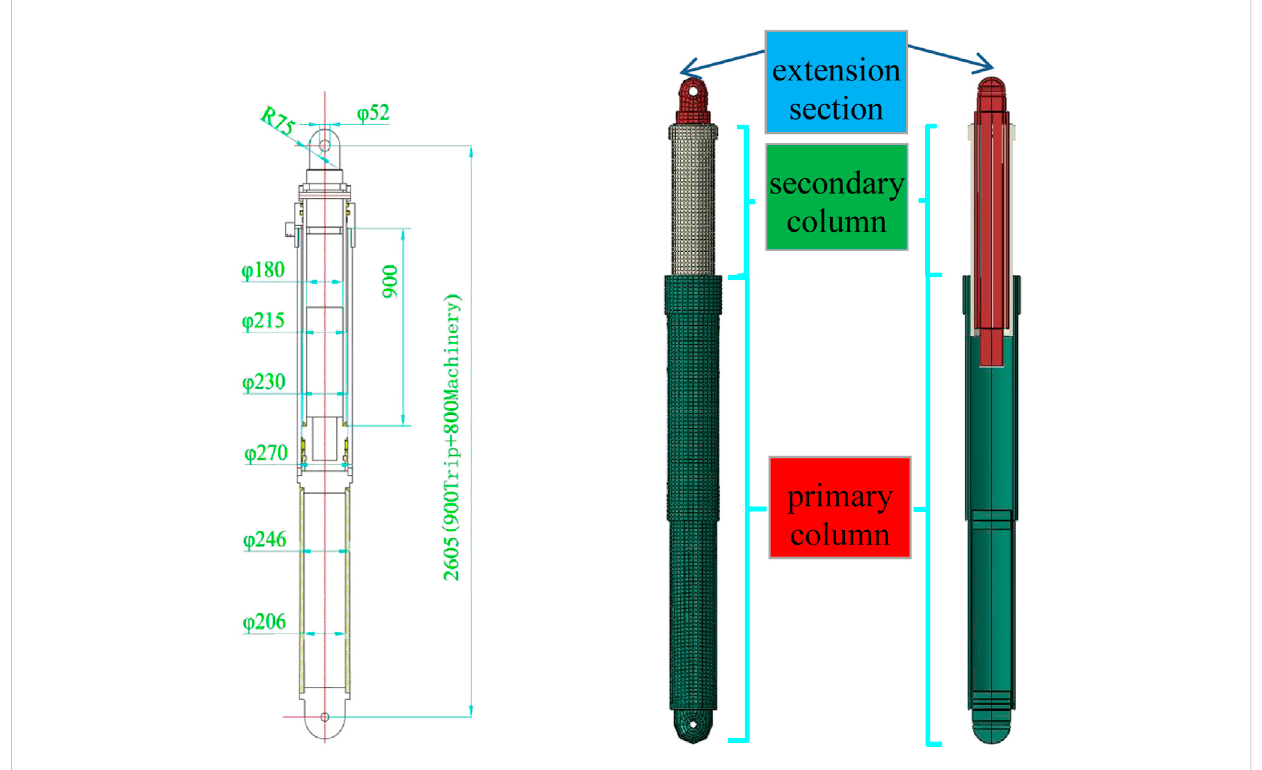
FIGURE 10 Design drawings and model drawings of the conventional column.